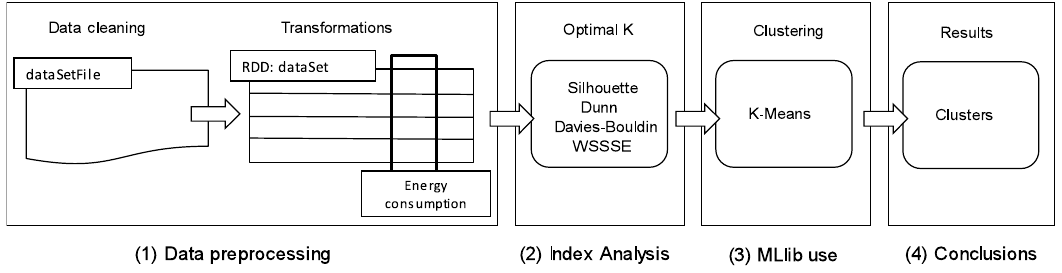
Figure 1. Proposed methodology. RDD: Resilient Distributed Dataset; MLlib: Machine Learning Library; WSSSE: Within Set Sum of Square